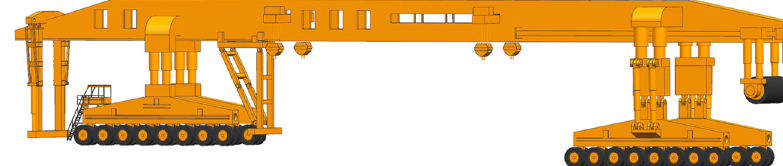
Figure 30. Summary solution one.